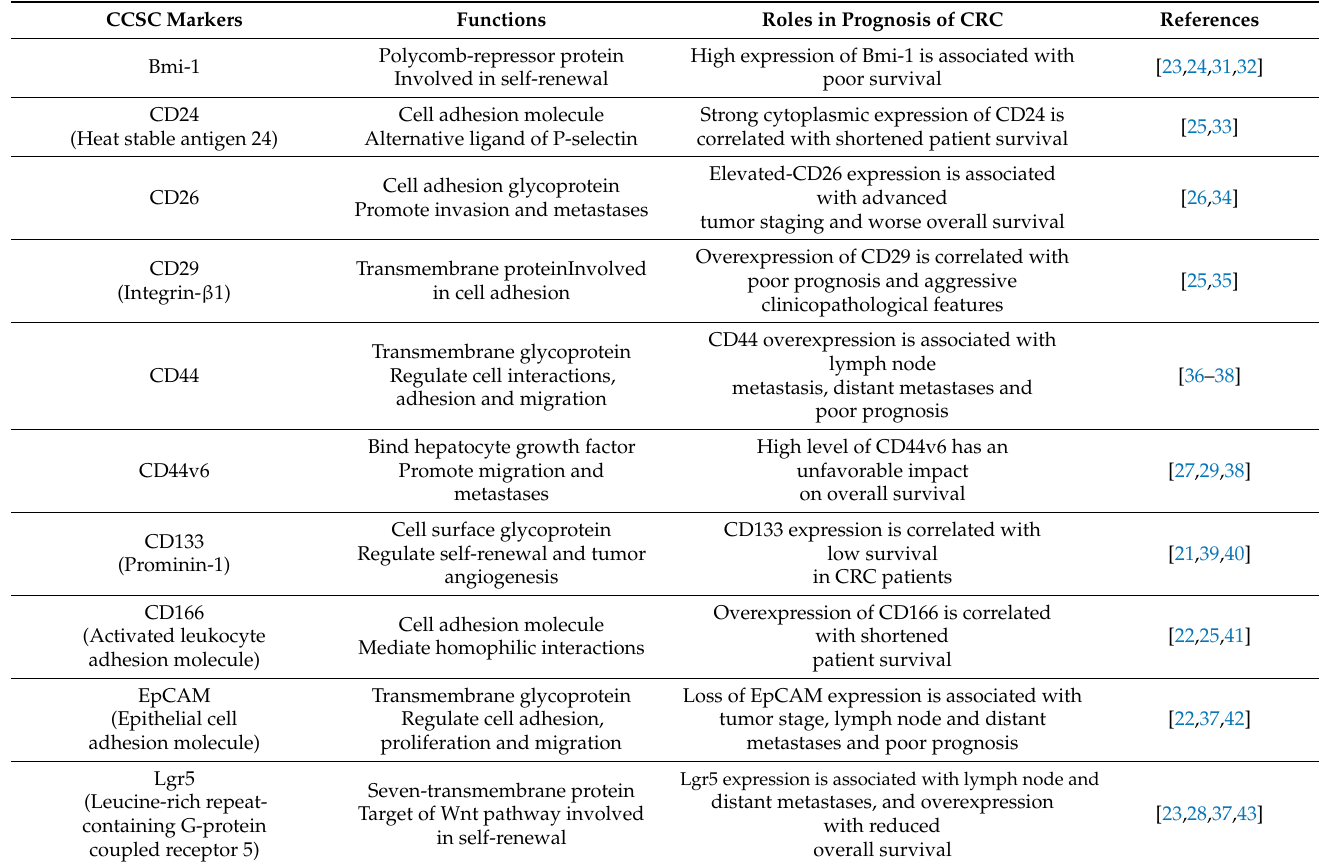
Table 2. Functions and roles in CRC prognosis of CCSC